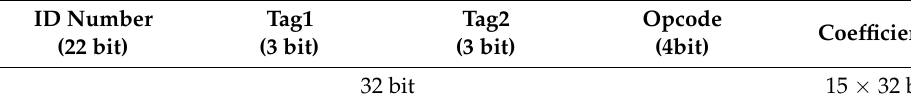
Table 2. Instruction format.